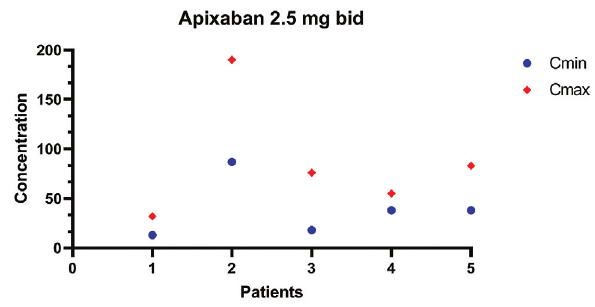
Fig. 1 Apixaban trough Cmin and Cmax levels (2hours after inges- tion) are shown for patients on Apixaban 5mg bid.